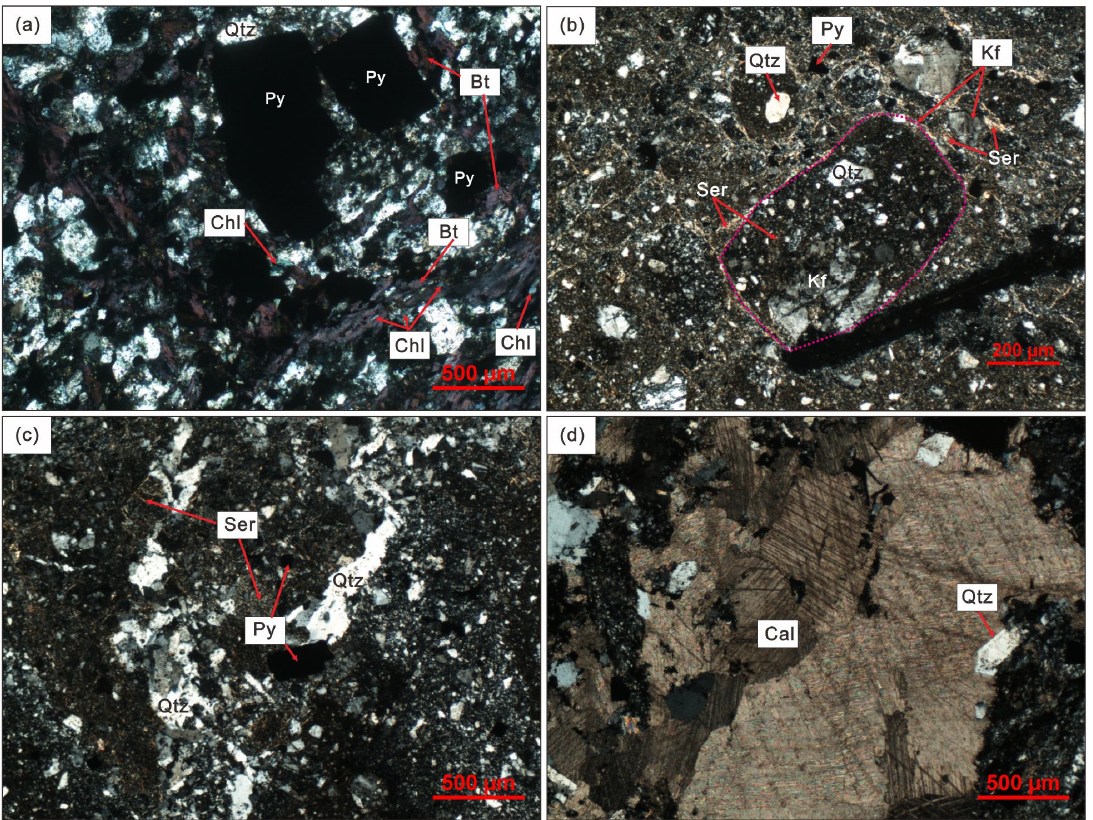
Figure 5. Photomicrographs of hydrothermal alterations of the Longquanzhan gold deposit. ( a ) chloritization, silicification and pyritization in amphibolite wall rocks; ( b ) pyritization, sericitization, and silicification in monzogranite; ( c ) sericite alteration assemblages are crosscut by a quartz-pyrite vein in monzogranite; and ( d ) calcite and quartz in carbonation stage in monzogranite. Abbreviations: Py =pyrite; Ser = sericite; Qtz = quartz; Kf = K-feldspar; Pl = Plagioclase; Chl = chlorite; Bt = biotite; Cal = calcite.